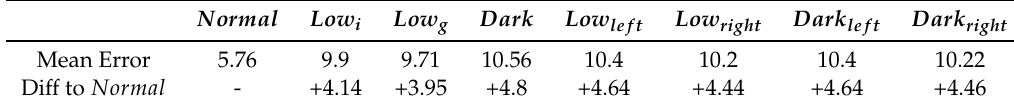
Table 1. Mean error of the MPIIGaze protocol under various lighting conditions.